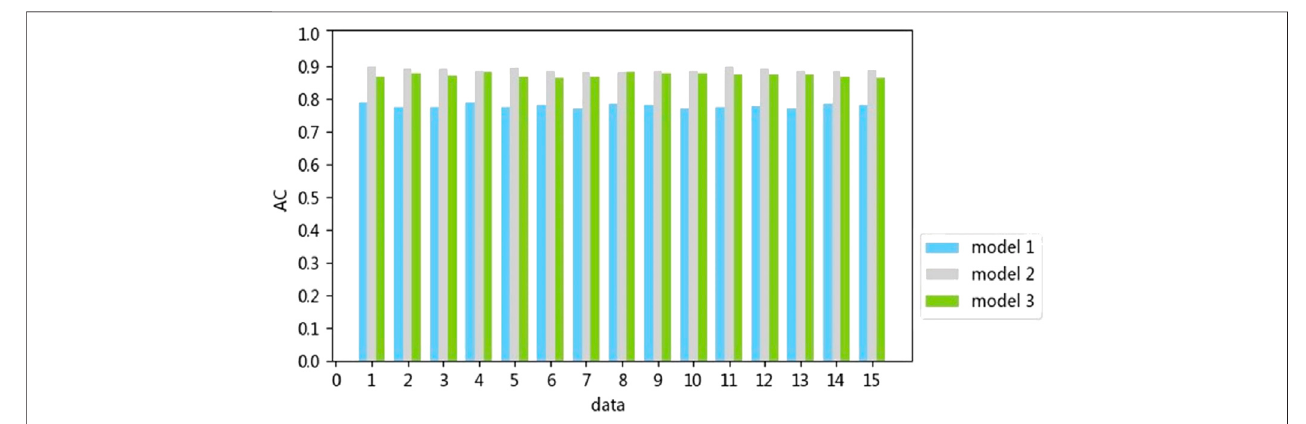
FIGURE 5 | Comparison of different attack gene feature